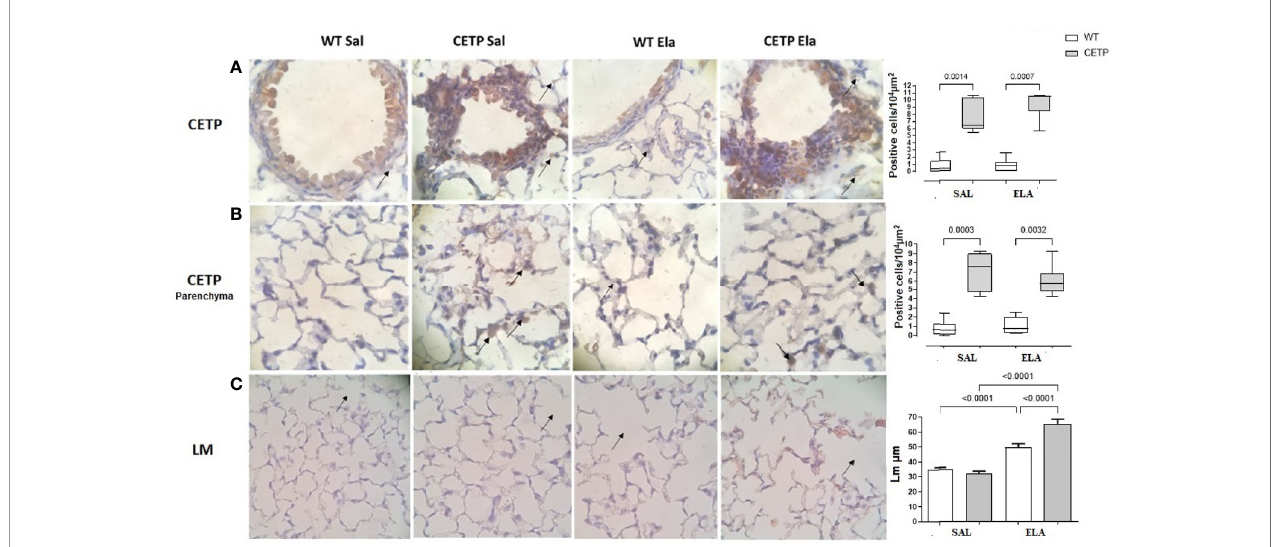
FIGURE 12 | Photomicrograph of stained slides for immunohistochemistry analysis of CETP in airways (A) , lung parenchyma (B) and mean linear intercept (LM) by dot count of airway spreads (C) from WT and huCETP mice after elastase-induced emphysema (ELA) or saline (SAL). Representative images of photomicrographs: CETP magni fi cation ×1,000 and (LM) ×400. Values expressed as median and percentiles 25 and 75 were analyzed by Kruskal – Wallis test with original FDR method of Benjamini and Hochberg post-test. The values were expressed as mean and standard deviation were analyzed by ANOVA with two-stage linear step-up procedure of Benjamini, Krieger, and Yekutieli post-test. p < 0.01, (n =